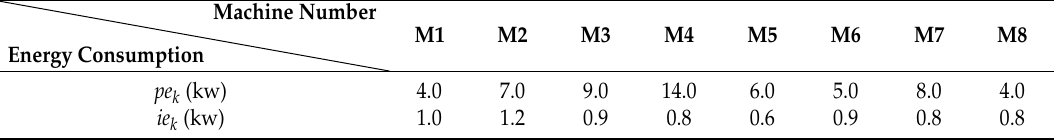
Table 3. The energy consumption per unit time of